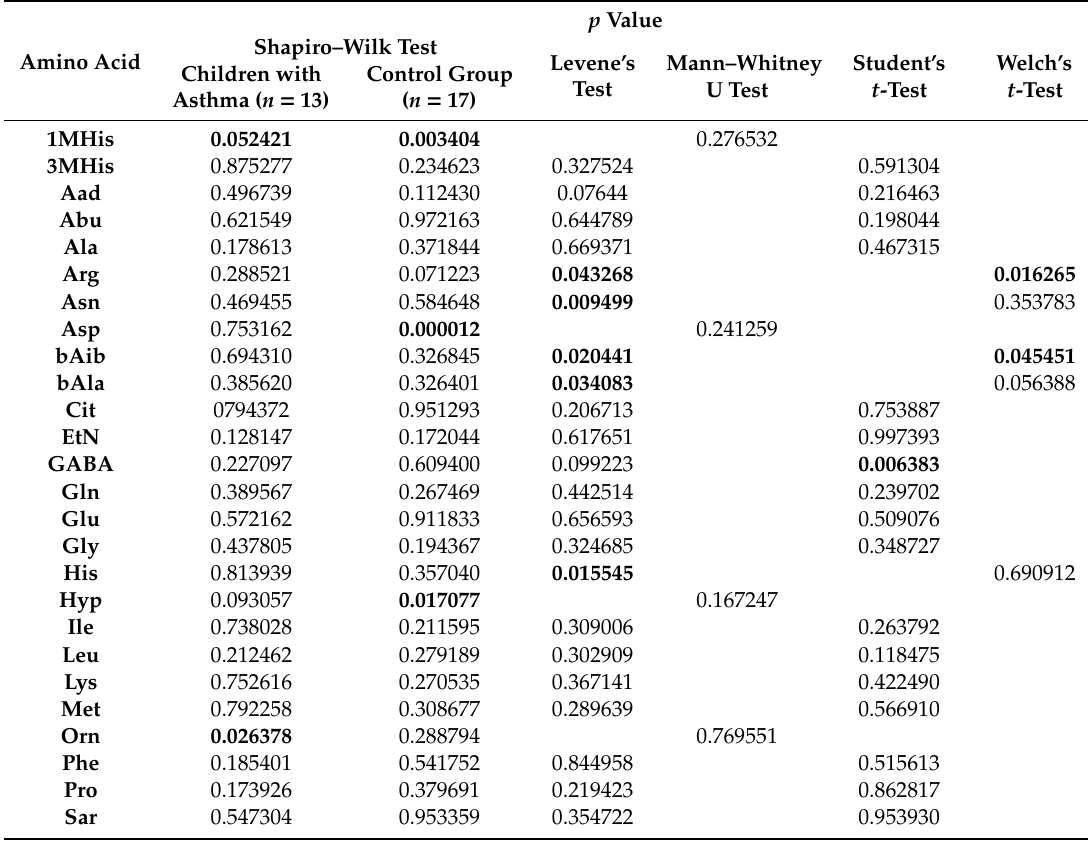
Table 3. Results of univariate statistical analysis of serum-free amino acids in children with asthma and the control group. Bold type for p values indicates statistical